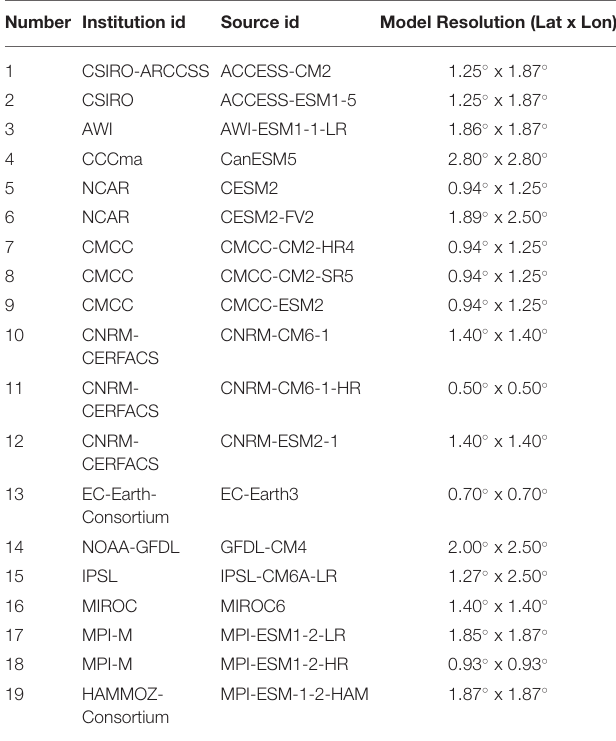
TABLE 1 | 19 selected CMIP6 climate models used for the analysis in this